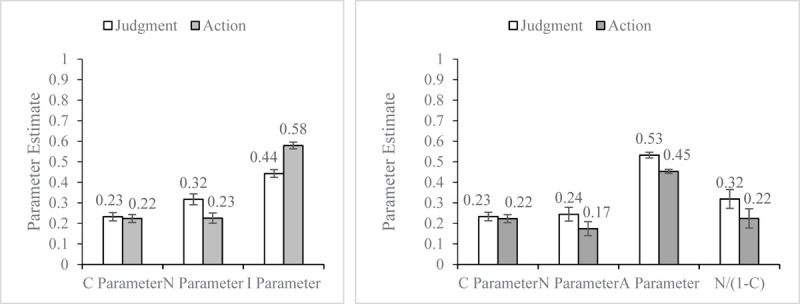
Results of Study 3b by Gawronski et al. (2017) obtained from the CNI model (left) and CAN algorithm (right). Error bars represent ± 1 SE.